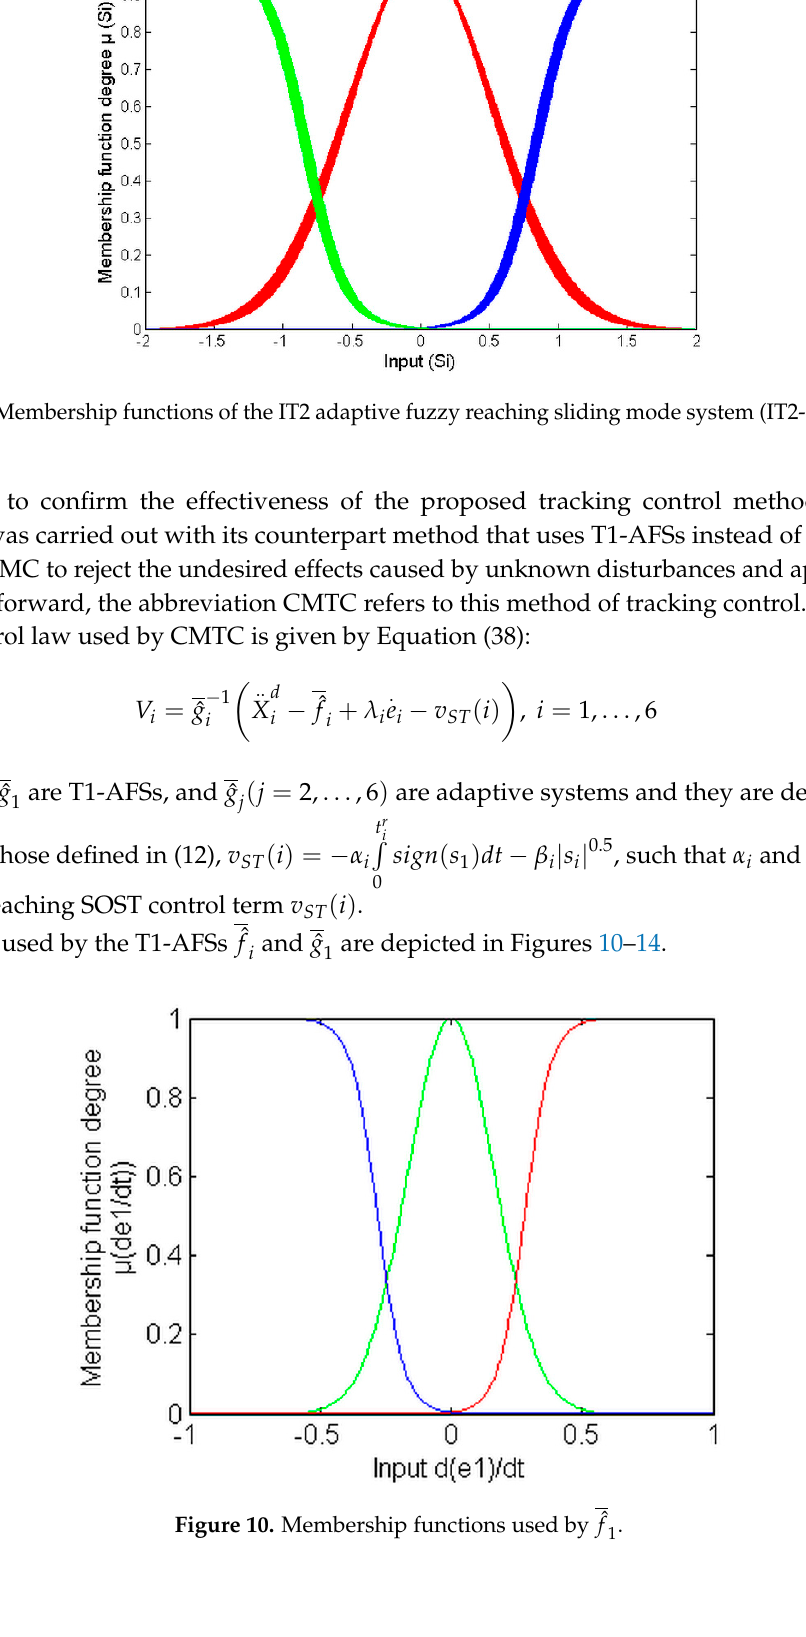
Figure 10. Membership functions used by 1